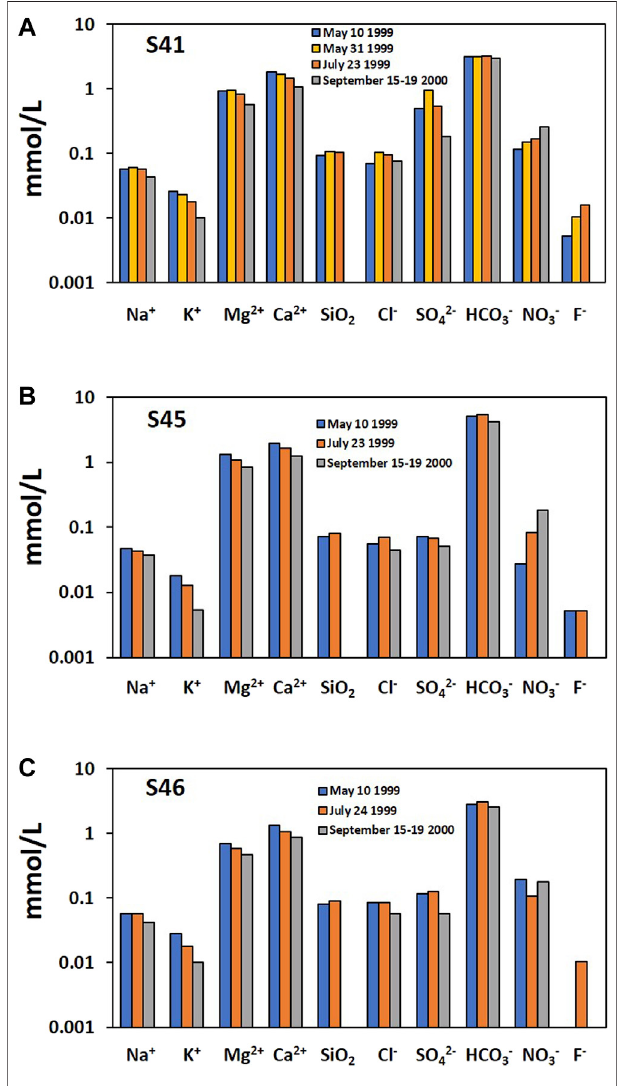
FIGURE12| ThetemporalvariationofmajorcompositionsatthreeType Ⅱ springs in the precipitation events in Figure 2 . The data in 2000 were the average of 10 samples collected for 5 days (Kim et al.,